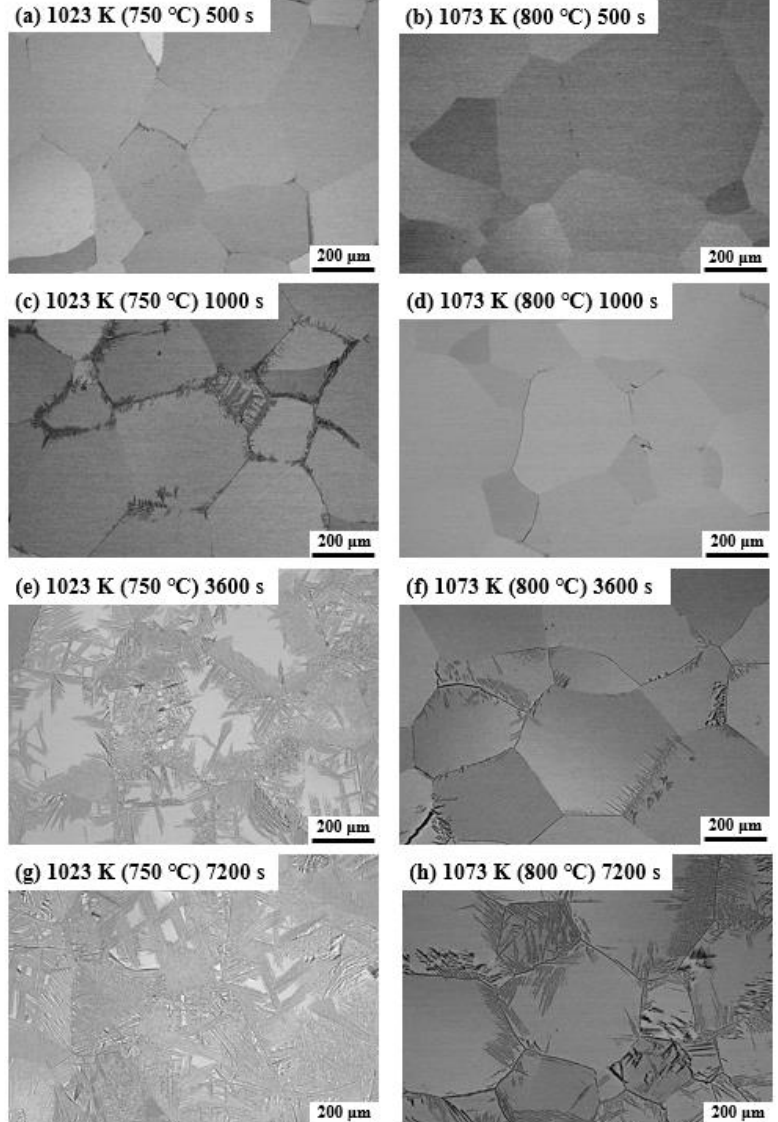
Figure 6. Microstructure changes during holding at 1023 and 1073 K (750 °C and 800 °C, respectively) after cooling from 1193 K (920 °C) in the (α + β) dual -phase region. Holding time was ( a – b ) 500, ( c – d ) 1000, ( e – f ) 3600, and ( g – h ) 7200 s at each temperature.